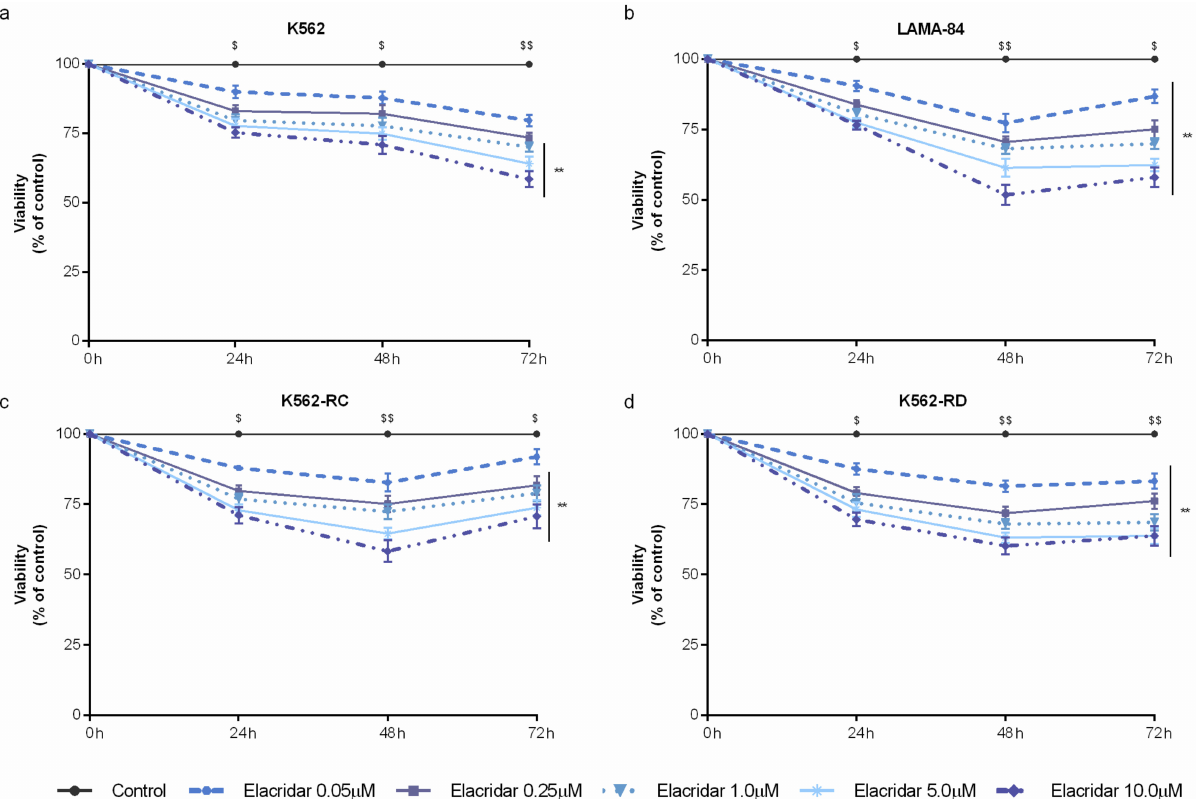
Figure 2. Dose–response curves of elacridar on sensitive and imatinib-resistant CML cell lines. K562 ( a ), LAMA-84 ( b ), K562-RC ( c ), and K562-RD ( d ) cells were incubated in the absence and presence of different concentrations of elacridar as monotherapy during 72 h. Results were expressed as a percentage (%) normalized to control and represent the mean ± SEM obtained from nine independent experiments. ** p < 0.01; comparison with control); $ p < 0.05, $$ p < 0.01 (comparison with time 0